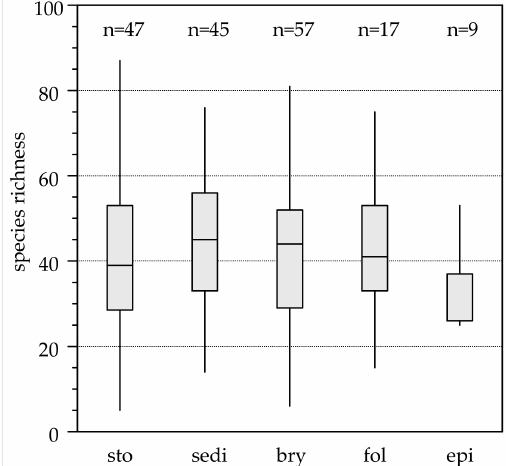
Figure 3. Species richness for each substrate. Mean species numbers per microhabitat were: stones = 39, sediment = 45, bryophytes = 43, epiphytic on filamentous green-algae = 39 and leaf litter = 32. Substrates: sto = stones, sed = sediment, bry = bryophytes, epi = epiphytic on filamentous green algae, lea = leaf litter. The lower edge of the grey boxes shows the 1st quartile, the upper edge the 3rd quartile, the line in boxes shows the median, and the whiskers show the minima and the maxima.